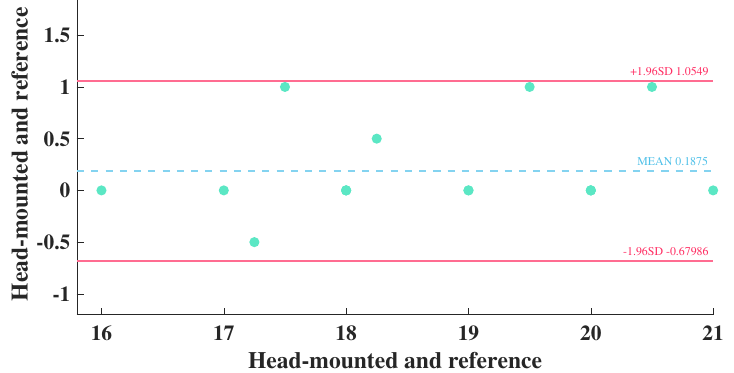
Figure 9. Bland–Altman distribution of respiration rates measured by the two